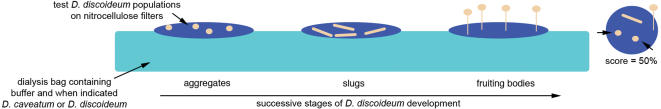
Diagram accompanying Tables 1, 2 and S1.